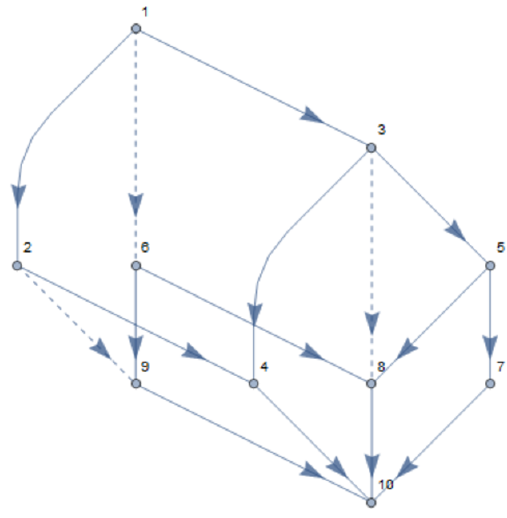
(a) Topology of the RG-(cid:13)ow at (cid:11) sponding to (cid:12)gure 9. Figure 11. Graphical representation of the (cid:12)xed points and the skeleton of the invariant set at ( N c ; N f ) = (3 ; 15) both on the (cid:11) g = 0 and the (cid:11) g = (cid:11) nt